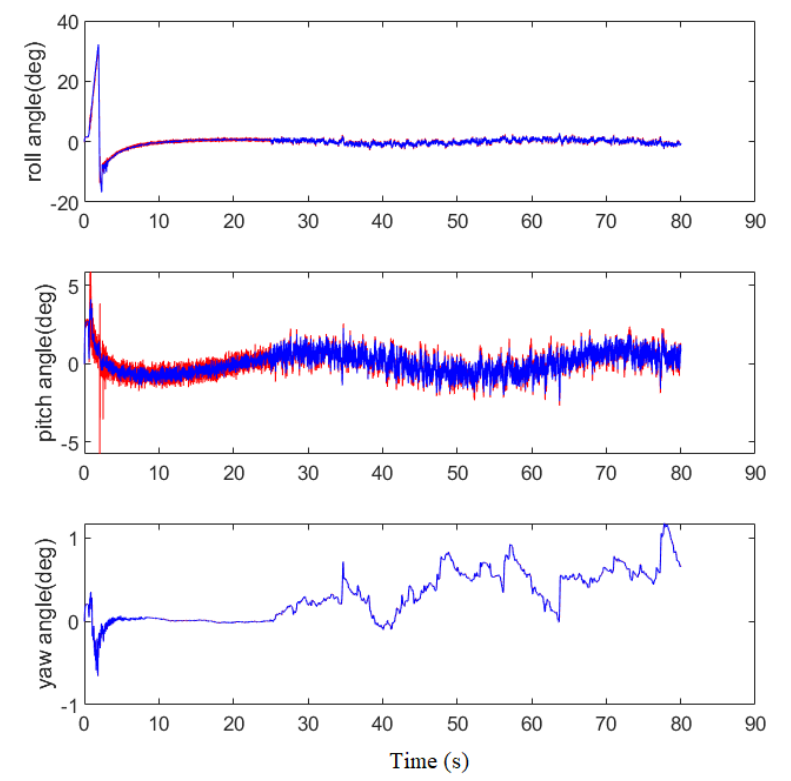
Figure 23. Multiplication fault: Euler angle estimation (red line–estimated angle, blue line–actual angle